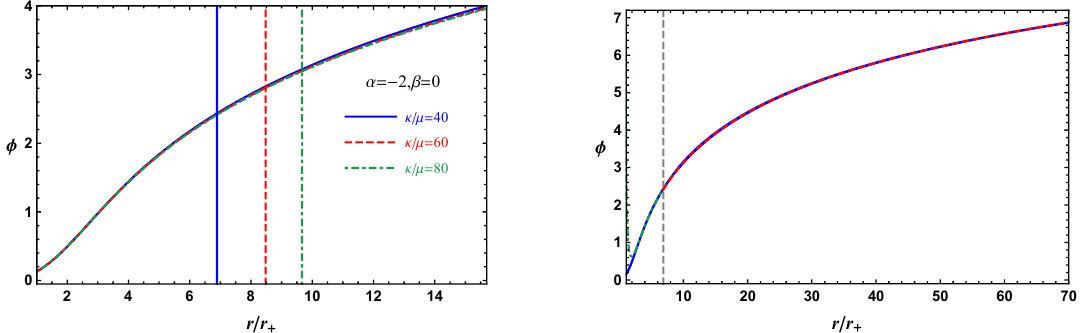
Figure 17 . Left: the evolution of φ for large amounts of the massive parameter κ/µ in the pure non- linear massive configuration case. Right: a comparison of the numerical solution (solid blue curve) of φ for κ/µ = 40 in the pure non-linear massive configuration case and fits to the relation (3.5) (green dashed curve) describing ER collapse before would-be inner horizon and analytic relation (6.3) (red dashed curve) after the would-be inner horizon. Here we have chosen T/T c = 0 . 995